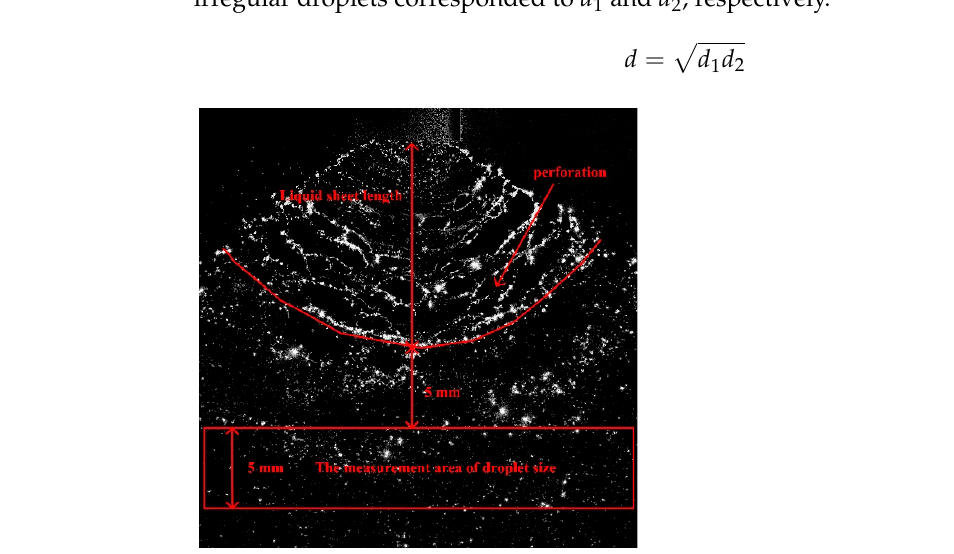
Figure 3. The diagram of test methods for the liquid sheet length and droplet